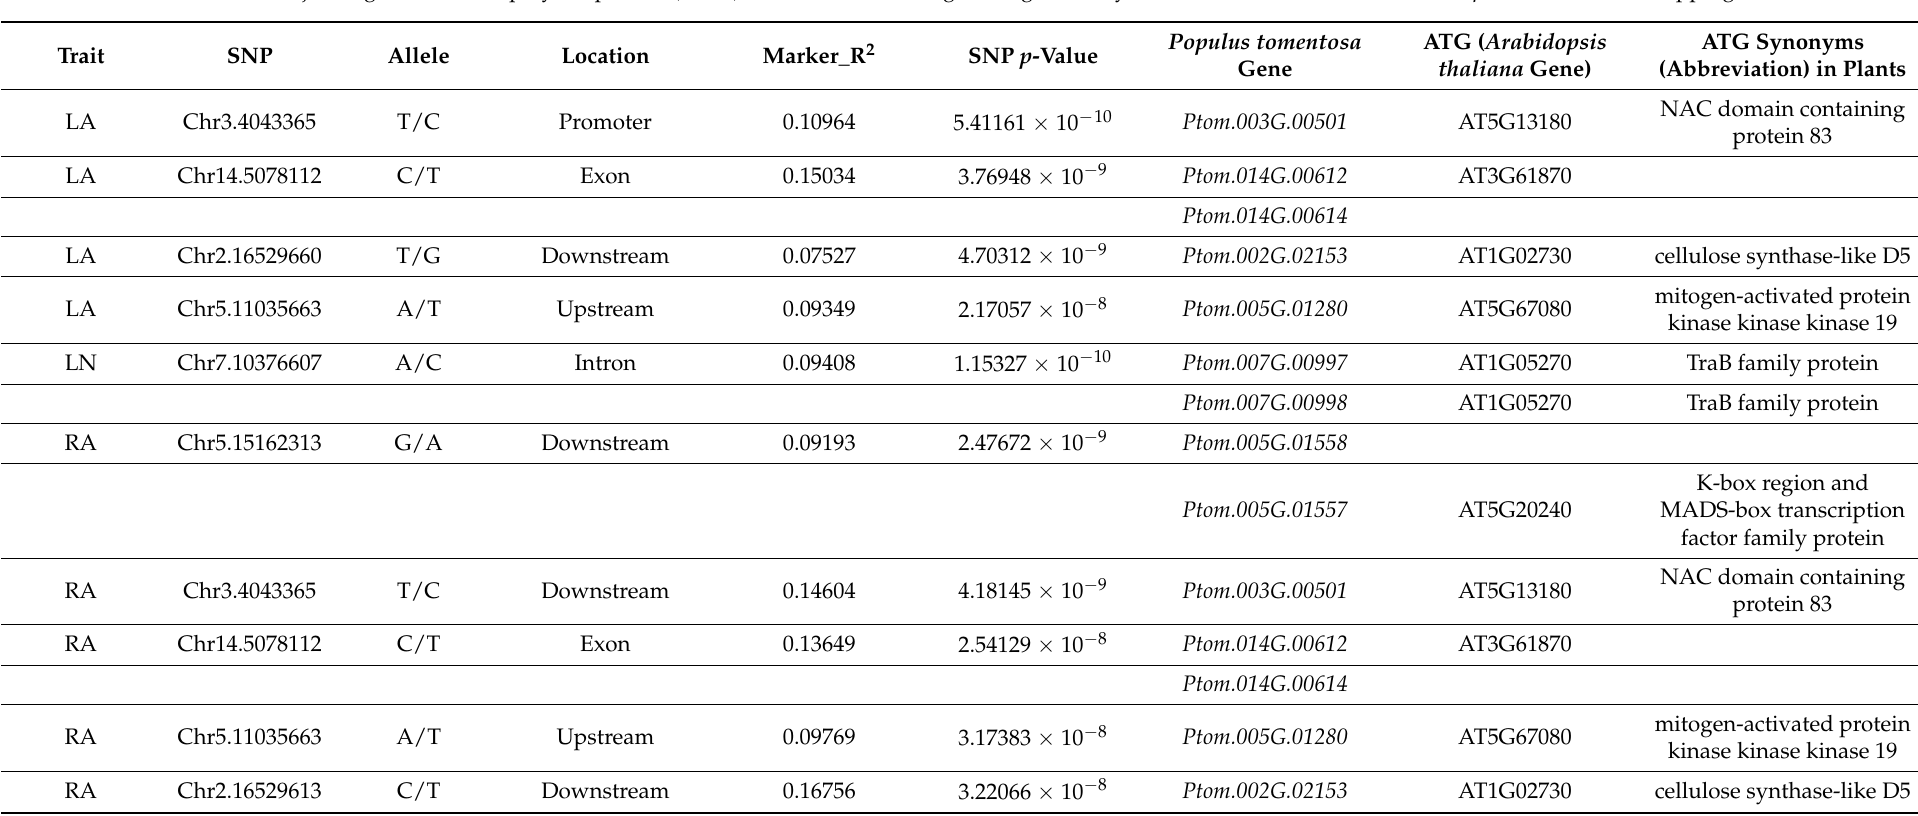
Table 2. Major single nucleotide polymorphisms (SNPs) linked to candidate genes significantly associated with lenticel traits in Populus association